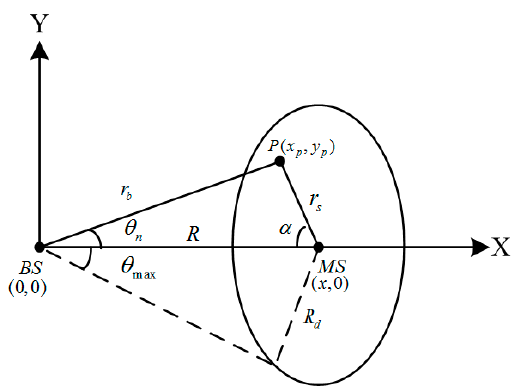
Figure 5. Geometry of circular disk of scatters model (CDSM).